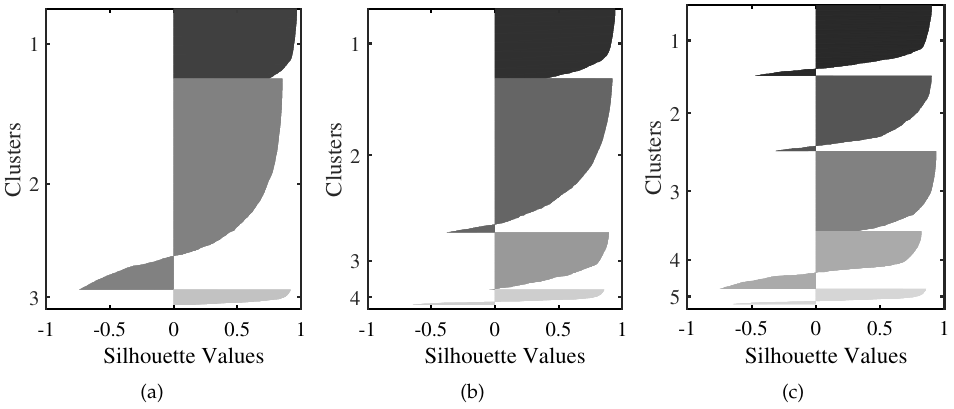
Figure 3. The silhouette indices of a clustering setup establishing ( a ) three, ( b ) four, and ( c ) five distinct groups of ω values of the central area drivers in Beijing. Inside each cluster, the more positive a silhouette index of a feature, the more similar is the feature to its group mates, which indicates a good clustering. ( a ) Here, the number of clusters is considered to be three. In this case, a group of drivers in the 2nd cluster is probably not optimally labelled. It is not possible to decide whether they belong to average-fuel-consuming drivers or to noisy patterns. Only the energy-saving drivers could be clearly located in the 1st cluster. ( b ) A minimal number of drivers with a negative silhouette index is found with 4 clusters. This clustering seems to have the best labelling. Noisy driver patterns are likely to be found in the 4th cluster. All energy-saving drivers are located in the 1st cluster and average-fuel-consuming drivers expand across two classes in the 2nd and 3rd cluster, respectively. ( c ) By increasing the number of clusters to five, drivers with negative silhouette indices appear even in the 1st cluster with small ω values. This depicts a clustering result which may not be considered as optimal, since almost all clusters accommodate dissimilar drivers inside